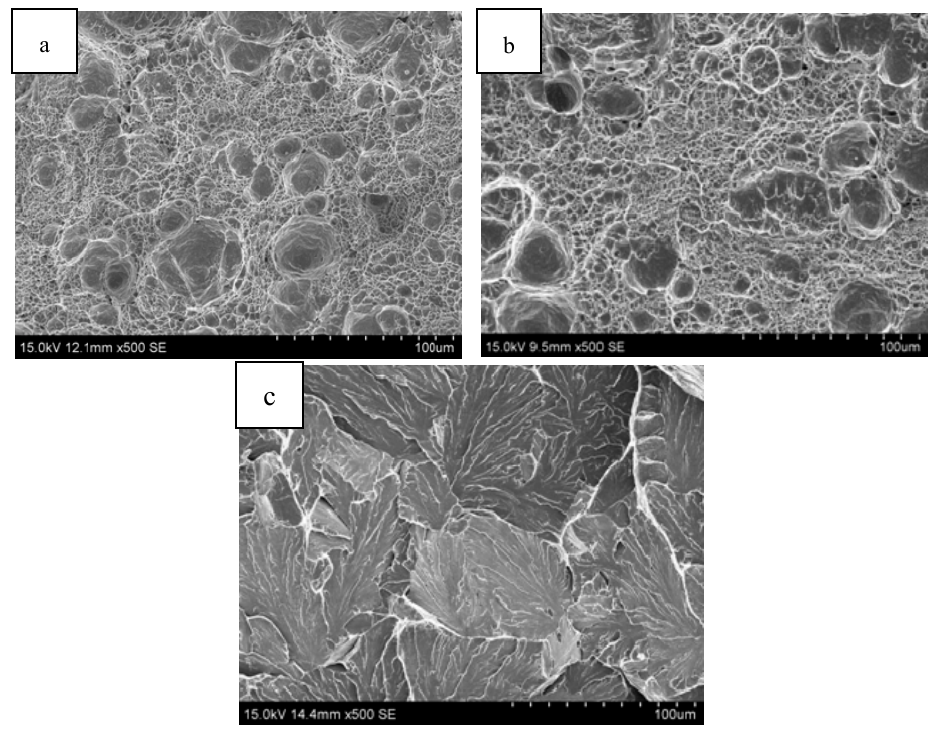
Figure 15. SEM micrographs showing surface morphologies resulting from impact fracture at − 20 °C of samples with different heat inputs of ( a ) 18 kJ/cm; ( b ) 25 kJ/cm; and ( c ) 81 kJ/cm.